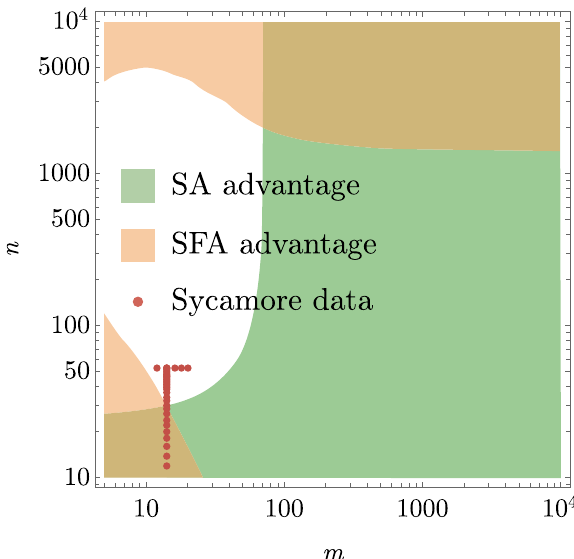
Fig. 1 Boundaries of an effective polynomial quantum speedup (Eq. (7)) for circuits with n qubits and m cycles (without accounting for memory constraints). Circuits that are too wide or deep have low fi delity, enabling a classical advantage. However, the Google Sycamore experiments (red dots) achieved a suf fi ciently high fi delity to enter the region of a quantum runtime advantage, denoted by the white region ( α C > 0). Only depths larger than 5 cycles are shown due to recent polynomial-time simulation results for shallow 2D circuits 32